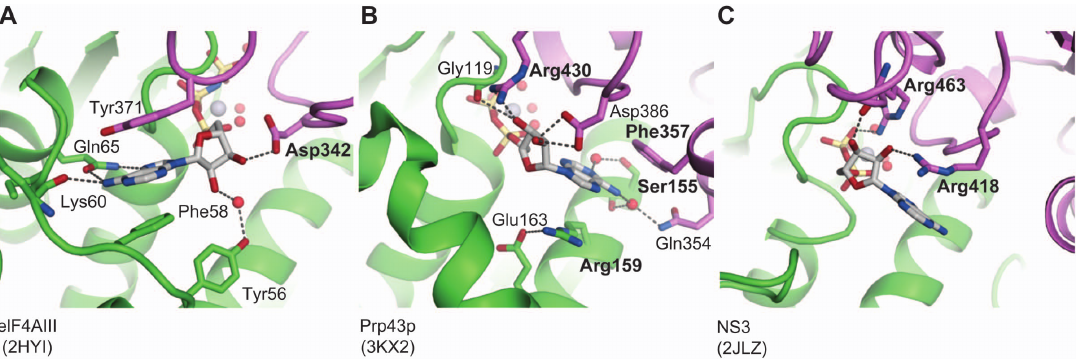
Figure 6 The nucleotide binding sites of Superfamily 2 helicases. (A) ADPNP bound to the DEAD-box protein eIF4AIII (RCSB entry 2HYI). The base is stacked between Phe58 and Tyr371. Lys60 and Gln65 from the Q motif are responsible for direct recognition of adenine. (B) ADP bound to the DEAH/RHA protein Prp43p. The base is stacked between Arg159 and Phe357. Interaction between the adenine ring and the side chains of Ser155 and Gln354 are mediated by two water molecules. (C) ADP bound to NS3/NPH II protein NS3 (RCSB entry 2JLZ). The base is completely exposed to the